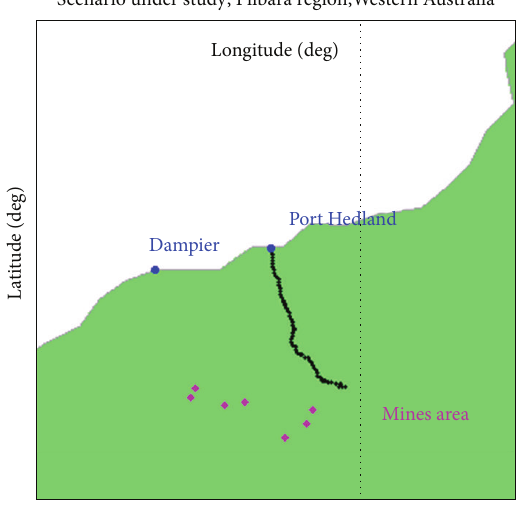
Figure 12: 13 elements array adaptive beam-forming antenna pattern—two nulls synthesis.